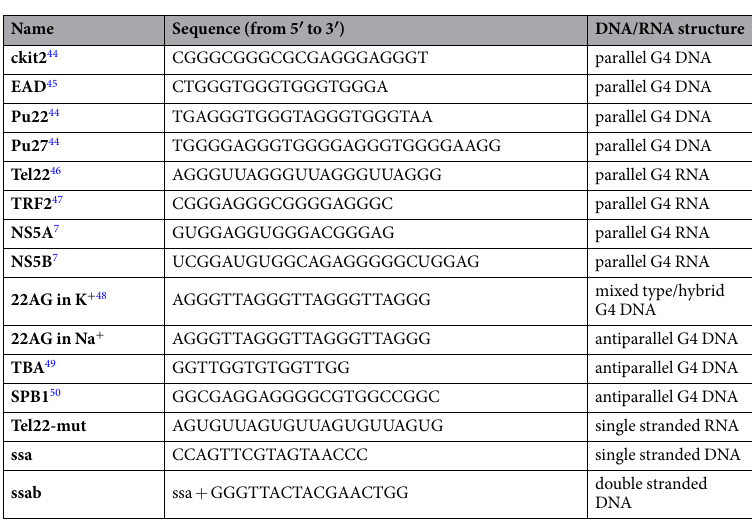
Table 1. Oligonucleotides used in this